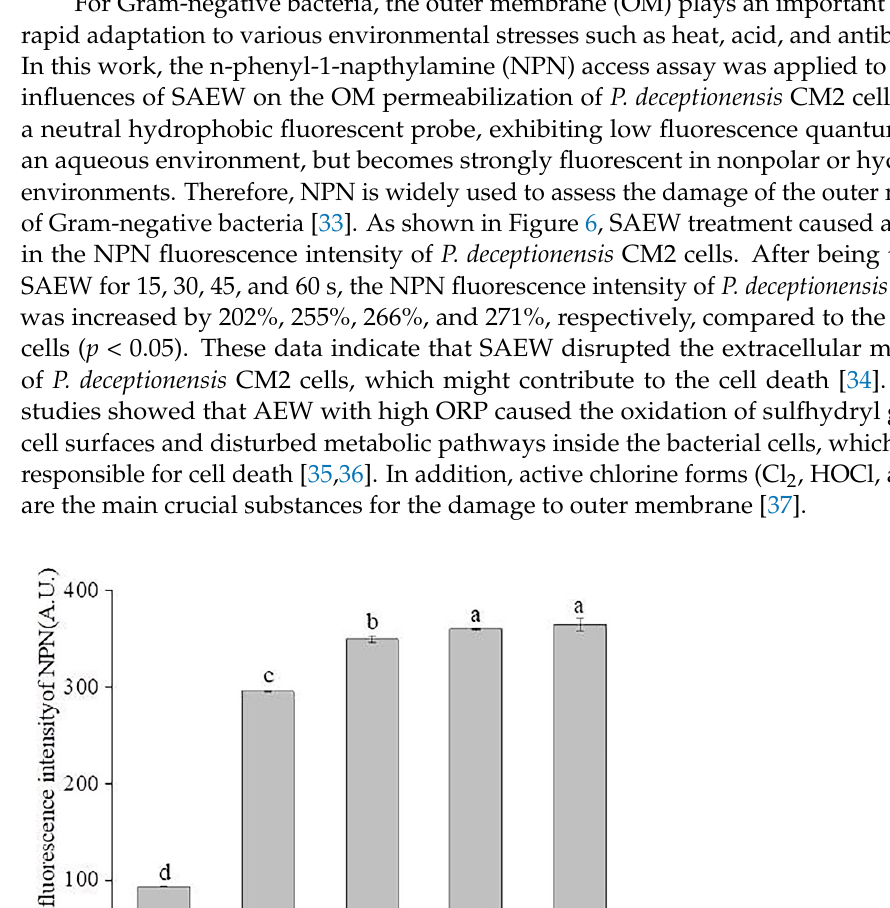
Figure 5. Fluorescence microscopic images of P. deceptionensis CM2 cells stained with propidium iodide (PI) (400 × ). ( a , f ): Control; ( b , g ): treated with SAEW for 15 s; ( c , h ): treated with SAEW for 30 s; ( d , i ): treated with SAEW for 45 s; ( e , j ): treated with SAEW for 60 s. ( a – e ) indicated PI staining observation; ( f – j ) indicated field observation.